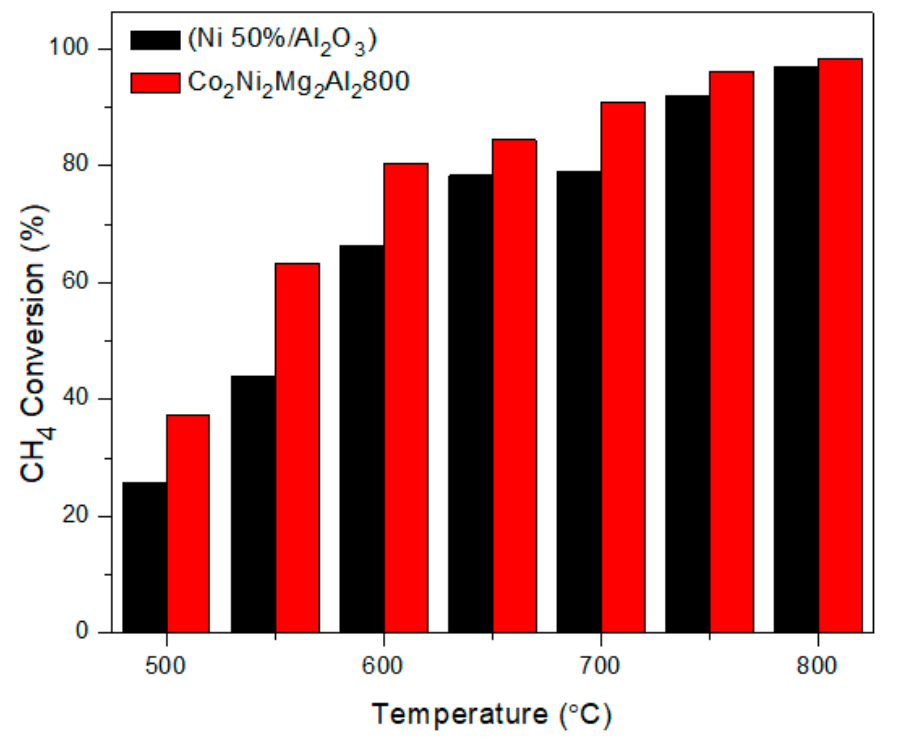
Figure 1. Evolution of the methane conversion in the dry reforming of methane (DRM) versus the reaction temperature for the catalyst Co 2 Ni 2 Mg 2 Al 2 800 and the commercial catalyst Ni (50%) / Al 2 O 3. Ni (50%)/Al 2 O 3 shows a lower conversion than Co 2 Ni 2 Mg 2 Al 2 800. This difference is clearly